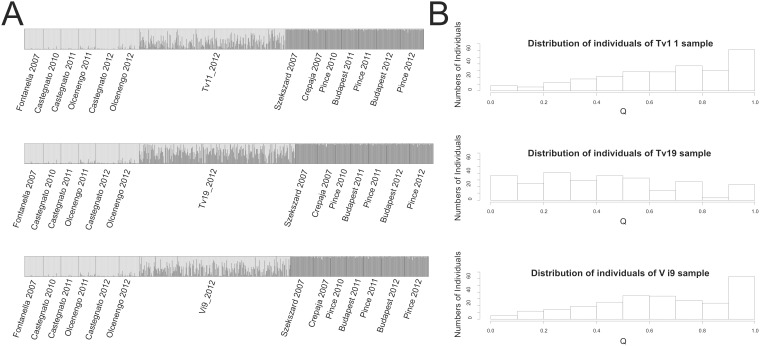
Admixture analysis of Tv11, Tv19 and Vi9 samples resulting from a Structure analysis based on 13 microsatellite loci.The most likely run generated with DISTRUCT version 1.0 is presented here [82]. (A) Assignment of WCR individuals and sperms to K = 2 genetically distinct clusters. For each adult or sperm sample, a vertical bar displaying two colours represents the proportion of the genome of the individuals that belongs to each of the two clusters. Adults or sperm samples are grouped by sampling location (the name of which is below the plot). (B) Distribution of the individual coefficient of coancestry Q for each sample, Tv11, Tv19 and Vi9.